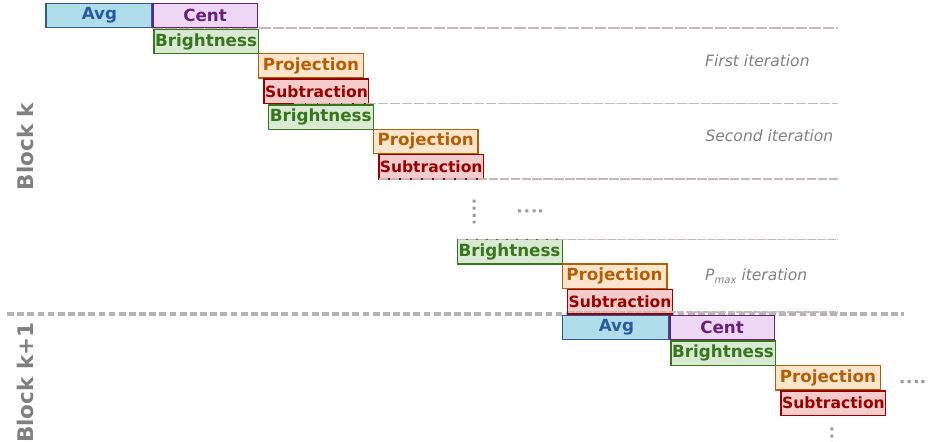
Figure 7. Dataflow of HyperLCA Transform hardware accelerator. Overlapping of operations within inter-loops and